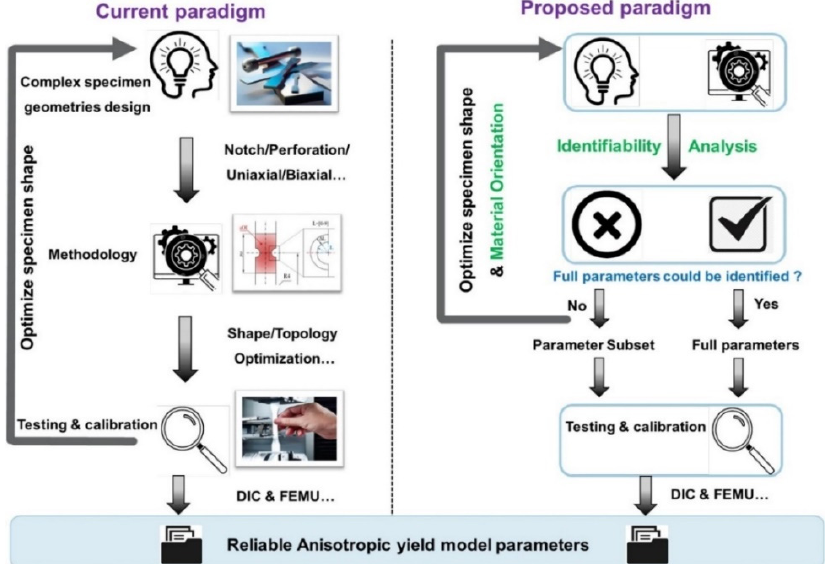
Figure 23. Comparison of current and proposed paradigm for non-conventional test design using specimens of complex geometries and parameters identification. Reprinted from Ref. [317], open access.